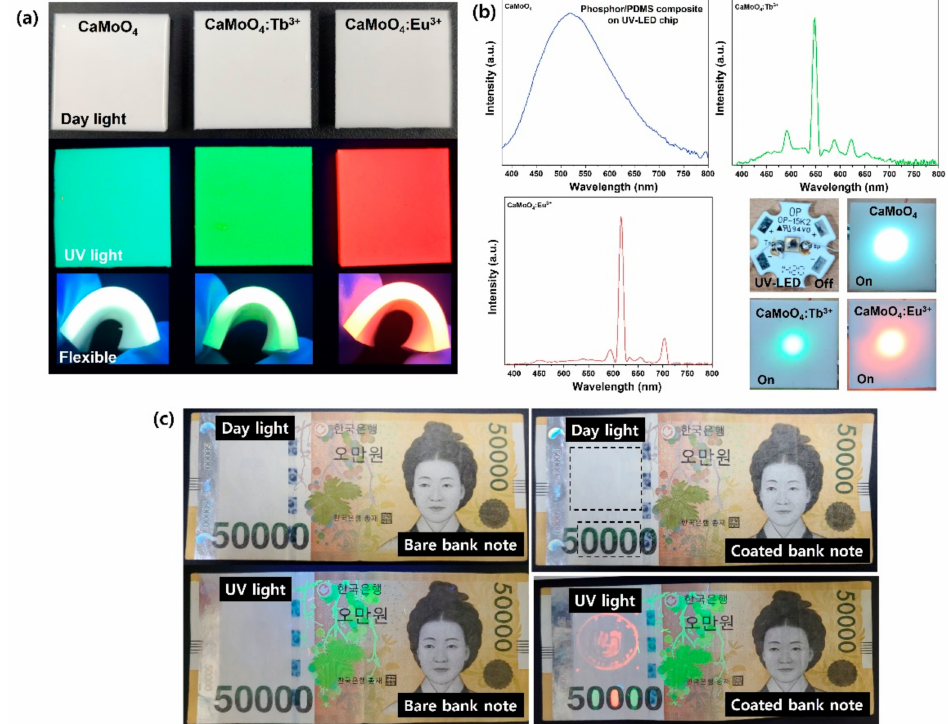
Figure 7. ( a ) Phosphors-PDMS composite under daylight and UV light. ( b ) Composite on UV-LED chip and a detected LED photometer. ( c ) Anti-counterfeiting ink painted on a